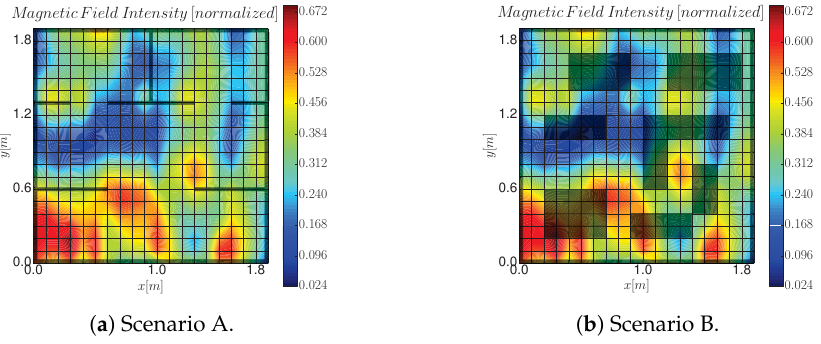
Figure 5. Scenarios employed to test Algorithm 1. Black polygons correspond to the obstacles and the underlying picture is the magnetic field intensity we aim to